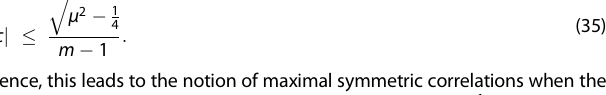
ffiffiffiffiffiffiffiffiffiffiffiffiffi q μ 2 (cid:6) 1